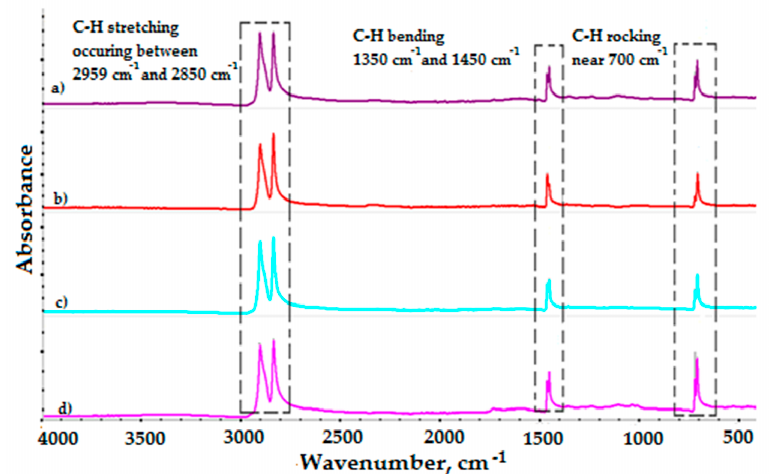
Figure 7. Fourier transform infrared spectroscopy (FTIR spectra) of: ( a ) the new HDPE geogrid sample, ( b ) the aged HDPE geogrid sample in leachate for 12 months at 25 °C, ( c ) the aged HDPE geogrid sample in leachate for 12 months at 45 °C, and ( d ) the aged HDPE geogrid sample in leachate for 12 months at 75 °C.